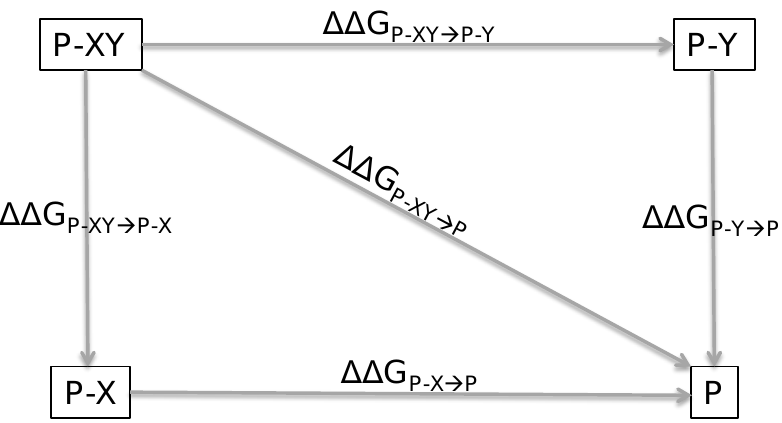
Figure 1. Schematic representation of a double mutant cycle. P-XY is the wild-type protein with the two residues X and Y. P-X and P-Y are the variants where Y and X are mutated, respectively, and P is the corresponding double mutant. The change in free energy upon mutation of X (or Y) is equal to G P-XY → P-Y (or G P-XY → P-X ) and G P-XY → P is the change in free energy of the double mutant.